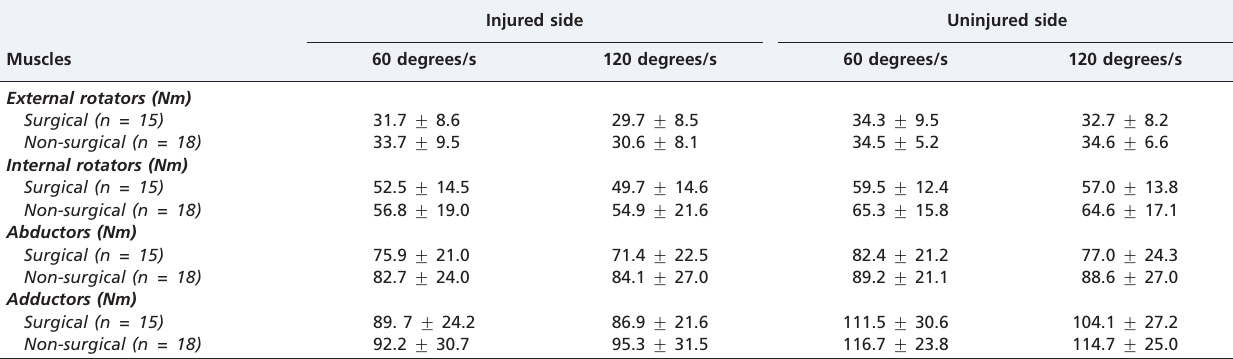
Table 1 - Peak torque for the internal and external rotator muscles and the horizontal abductor and adductor muscles of the shoulder at angular speeds of 60 and 120 degrees/s in athletes who had undergone surgical and non-surgical